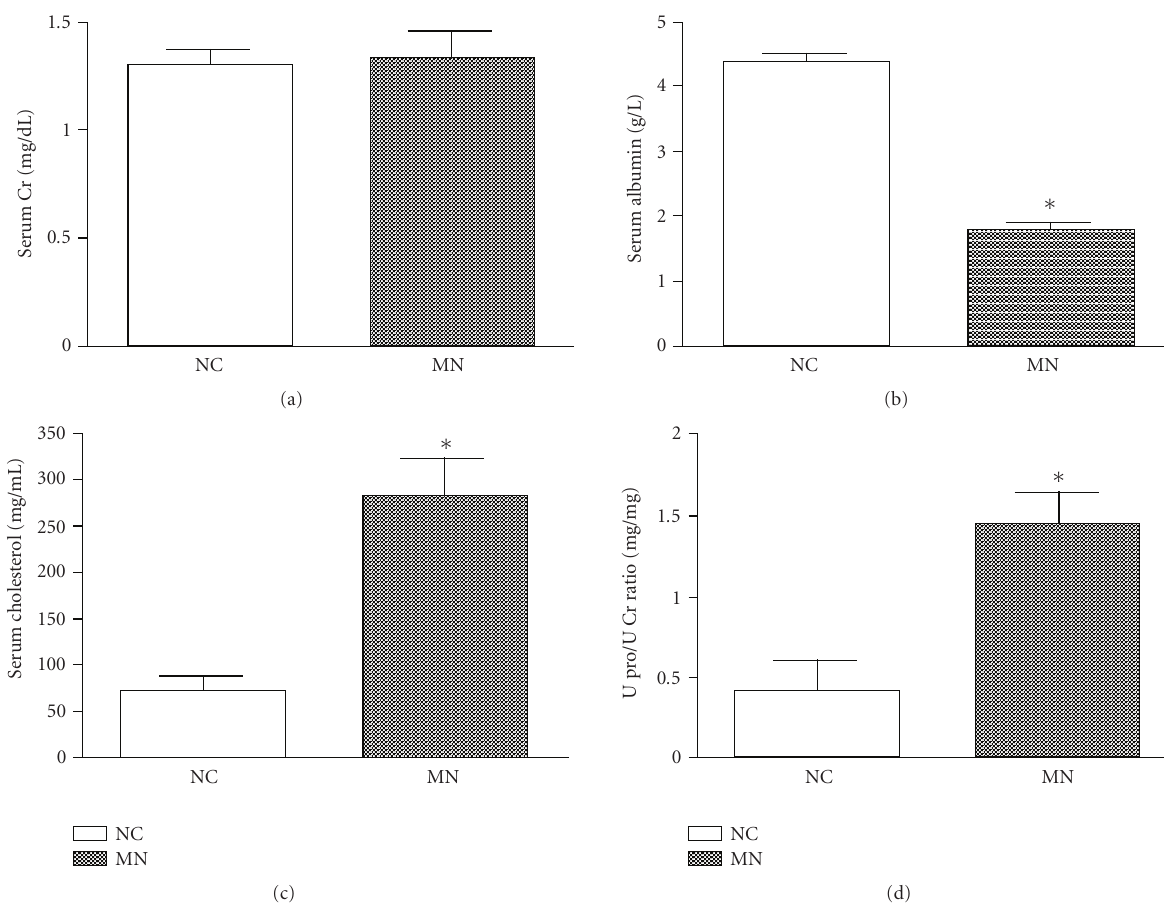
Figure 1: Clinical manifestations in mice with MN. The biochemical findings in MN mice revealed normal renal function (a), hypoalbuminemia (b), hypercholesterolemia (c), and overt proteinuria (d). ∗ P < .